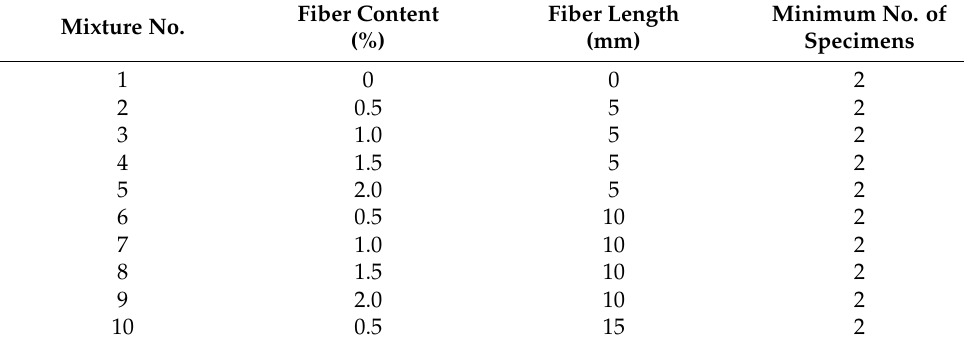
Table 4. Soil–fiber